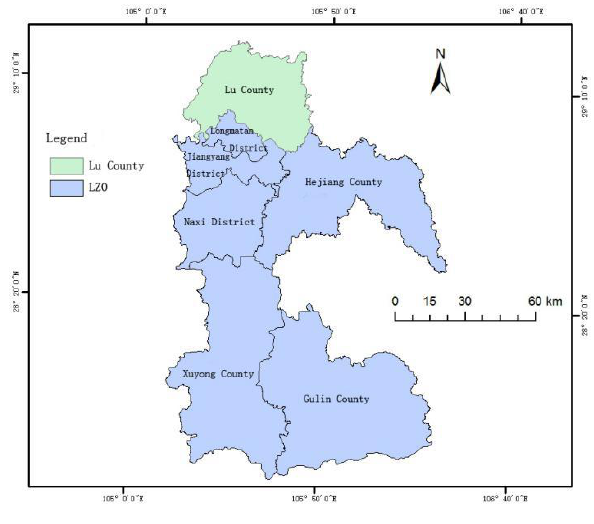
Figure 1 geographical location of the research